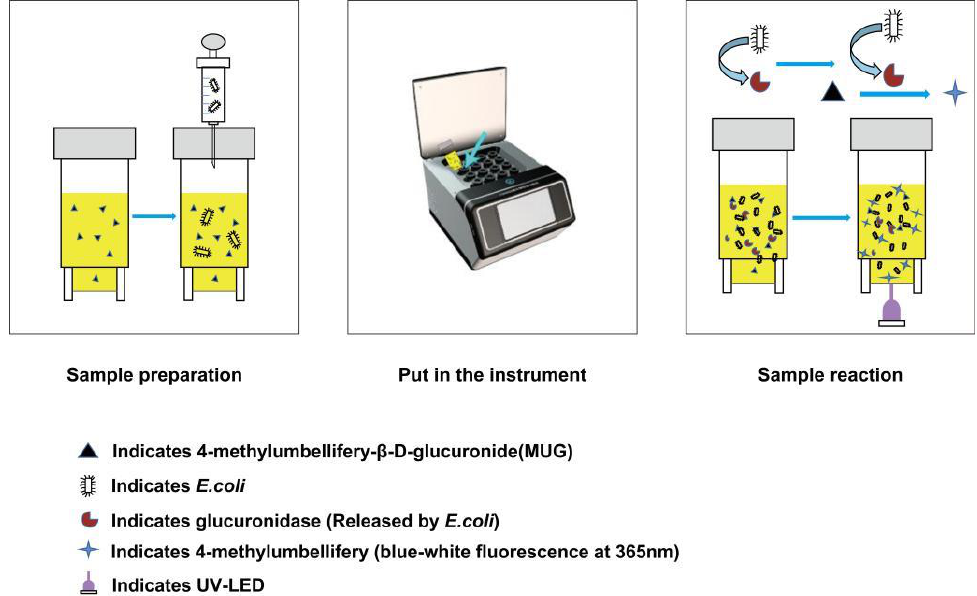
Figure 2. Detection process and principle schematic diagram of the microbial photoelectric detection system.